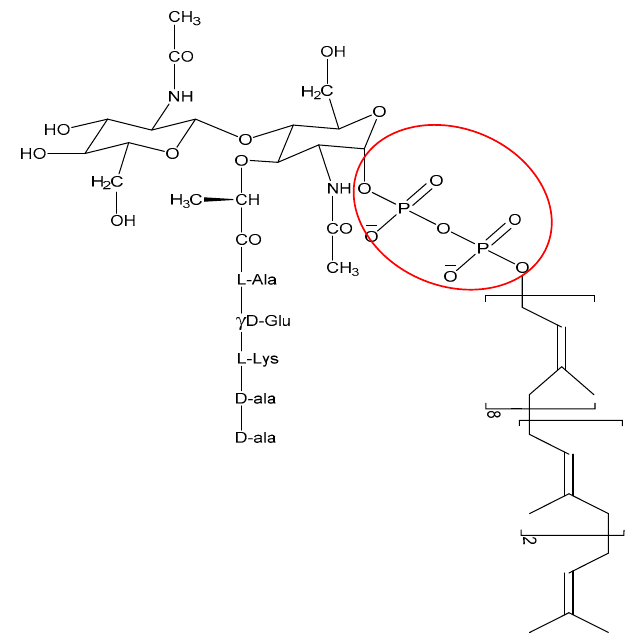
Figure 6. Structure of lipid II molecules with the pyrophosphate moiety circled in red.